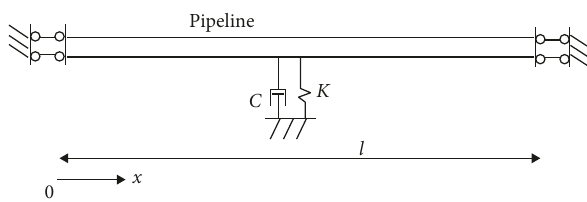
Figure 3: Pipeline transverse vibration calculation model and boundary conditions.